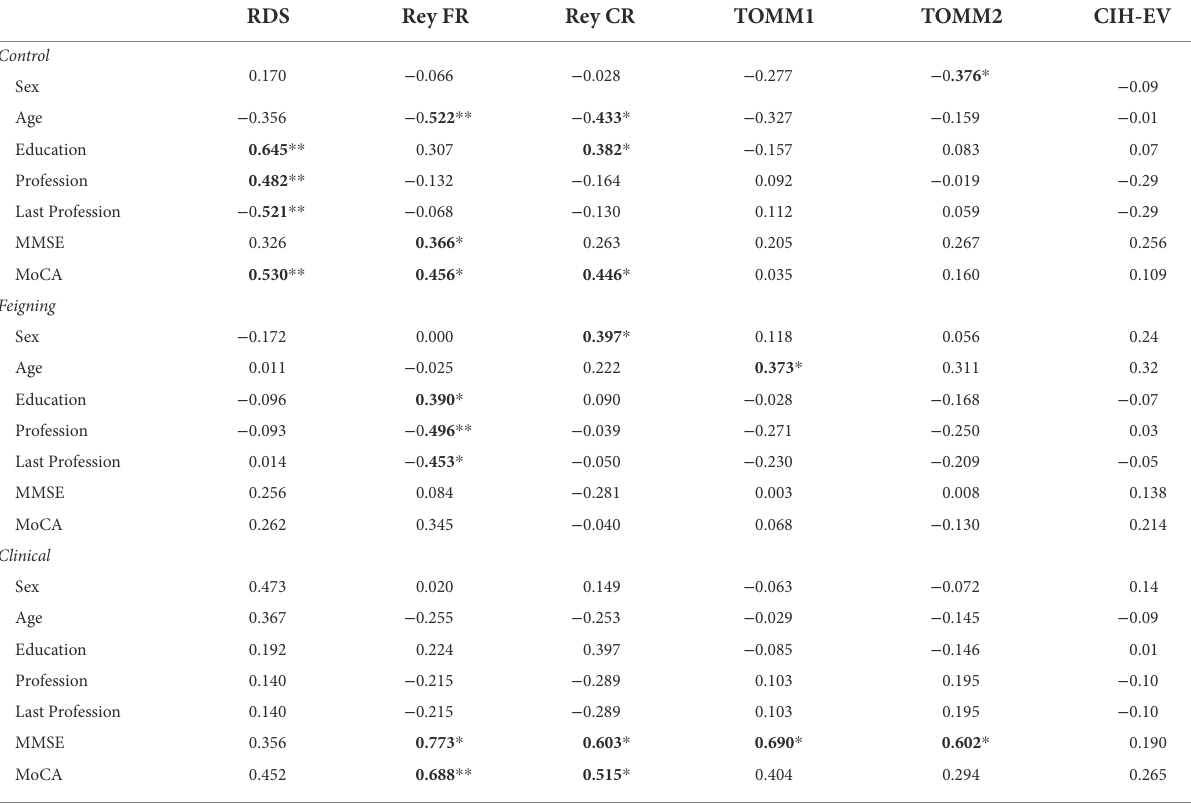
TABLE 2 Correlation between sociodemographic variables, neurocognitive functioning, and tests performance for each